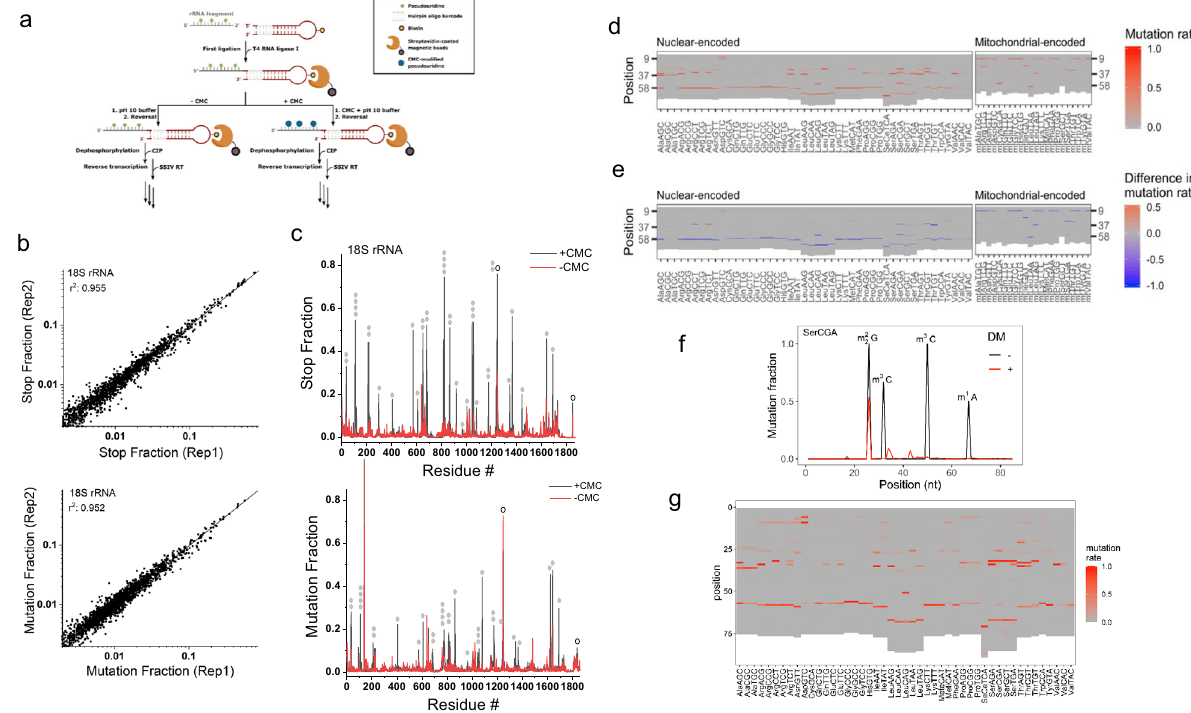
Fig. 2 Sequencing results from chemical and enzymatic treatment on bead. a Schematic representation of incorporating CMC reaction in MSR-seq for pseudouridine ( Ψ ) mapping. Total RNA was fragmented, 3 ′ end-repaired, and ligated to the capture hairpin oligonucleotide. CMC reaction was done on- bead before cDNA synthesis. b CMC reaction mapping replicates: Top graph shows the RT stop fraction and the bottom graph shows the mutation fraction for every residue in human 18 S rRNA among the biological replicates. c Stop and mutation fraction along 18 S rRNA without (red) and with CMC (black) treatment: Top graph shows the RT stop fraction and the bottom graph shows the mutation fraction at each nucleotide position. Known Ψ sites are marked by fi lled gray ovals, known m 1 acp 3 Ψ and m 6 2 A sites by open ovals. d Heat map showing the mutation signature at every nucleotide for the most abundant tRNA isodecoder in each isoacceptor family, no demethylase treatment. Nuclear-encoded and mitochondrial-encoded tRNAs are shown separately. e Heat map showing changes in mutation signature upon demethylase (DM) treatment at every nucleotide for the most abundant tRNA isodecoder in each isoacceptor family. Red indicates an increase and blue indicates a decrease in mutation fraction. f Mutation fraction across a tRNA Ser (CGA) isodecoder ± demethylase treatment (DM) showing the effective removal of base methylation. Known modi fi cations are indicated. g Same as ( d ), using overnight RT condition for library